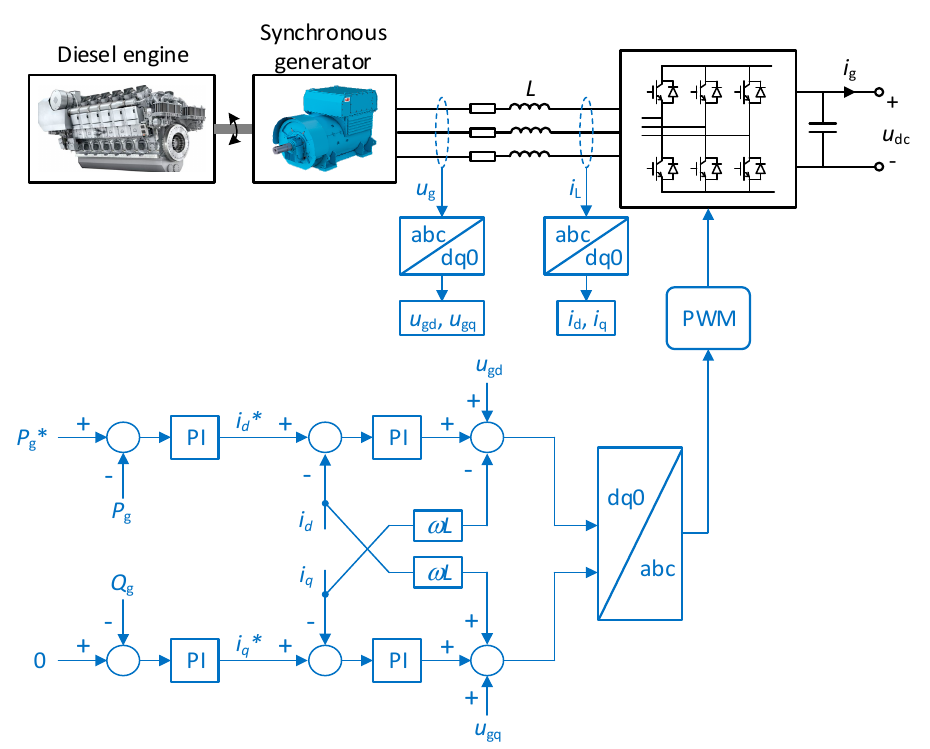
Figure 8. Control scheme of rectifier controller.